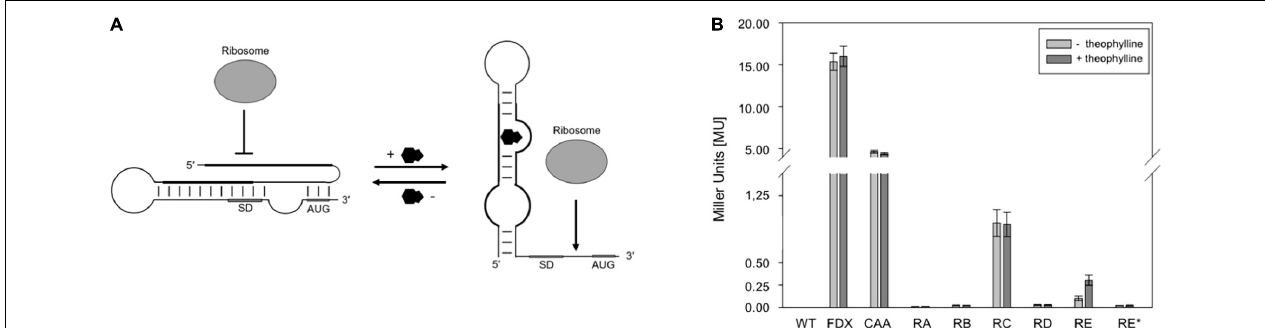
FIGURE 1 | Test of theophylline-dependent riboswitches A through E and E* in Hfx. volcanii . (A) Proposed mechanism of a theophylline-dependent riboswitch. In the absence of theophylline (black molecule), the SD sequence and AUG start codon are buried in a secondary structure. Upon binding of theophylline to the aptamer domain, the SD sequence and the AUG start codon are accessible to the ribosome. SD, SD sequence; AUG, AUG start codon (modified after Rudolph et al., 2015). (B) Experimental data on the switching behavior of theophylline-dependent riboswitches A through E, and E* in Hfx. volcanii . The bgaH reporter gene was placed under the control of one of the six theophylline-dependent riboswitches and the BgaH activity was determined by ONPG assay in the respective transformants after 36 h of growth (37 ◦ C; OD 600 of 1.2) in the presence or absence of 2 mM theophylline. The BgaH activity is given in Miller units ( Supplementary Table 3 ). WT, Hfx. volcanii WR340 wild type; FDX, leaderless bgaH expression in pFDXJB20 transformants; CAA, transformants containing pFDXJB20_CAA and therefore CAA repeats instead of theophylline aptamer; RA, transformants containing riboswitch A; RB, riboswitch B; RC, riboswitch C; RD, riboswitch D; RE, riboswitch E; RE*, riboswitch E* inserted in plasmid pFDXJB20_R. The experiments were performed in triplicates on three different